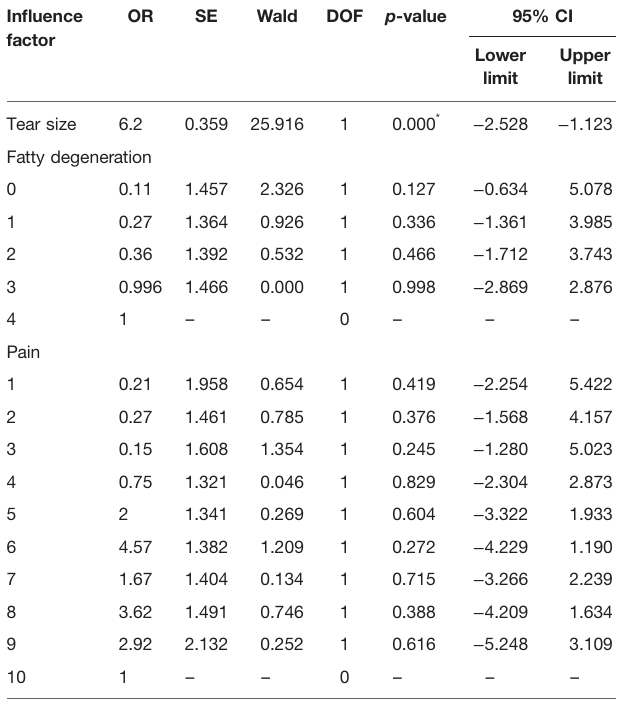
TABLE 4 | Pearson correlation analysis between different MRI results and UMI. TABLE 5 | Ordinal multinomial logistic regression analysis of factors affecting proximal humeral Fatty degeneration Tendon UMI Tear size grade ( X 1 ) thickness ( X 2 ) logarithm ( Z 3 ) Correlation coef fi cient